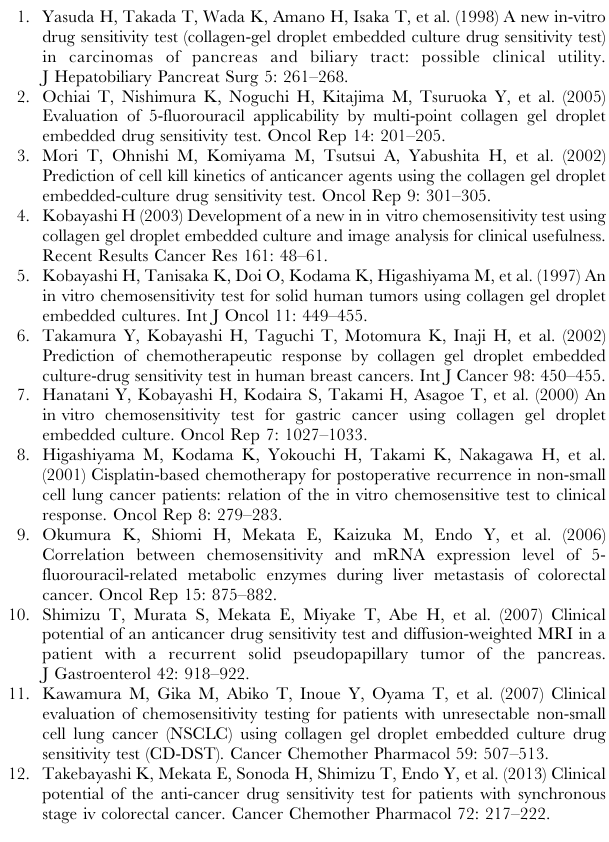
Agent T/C (%) in primary site (n=6) T/C (%) in lung metastasis